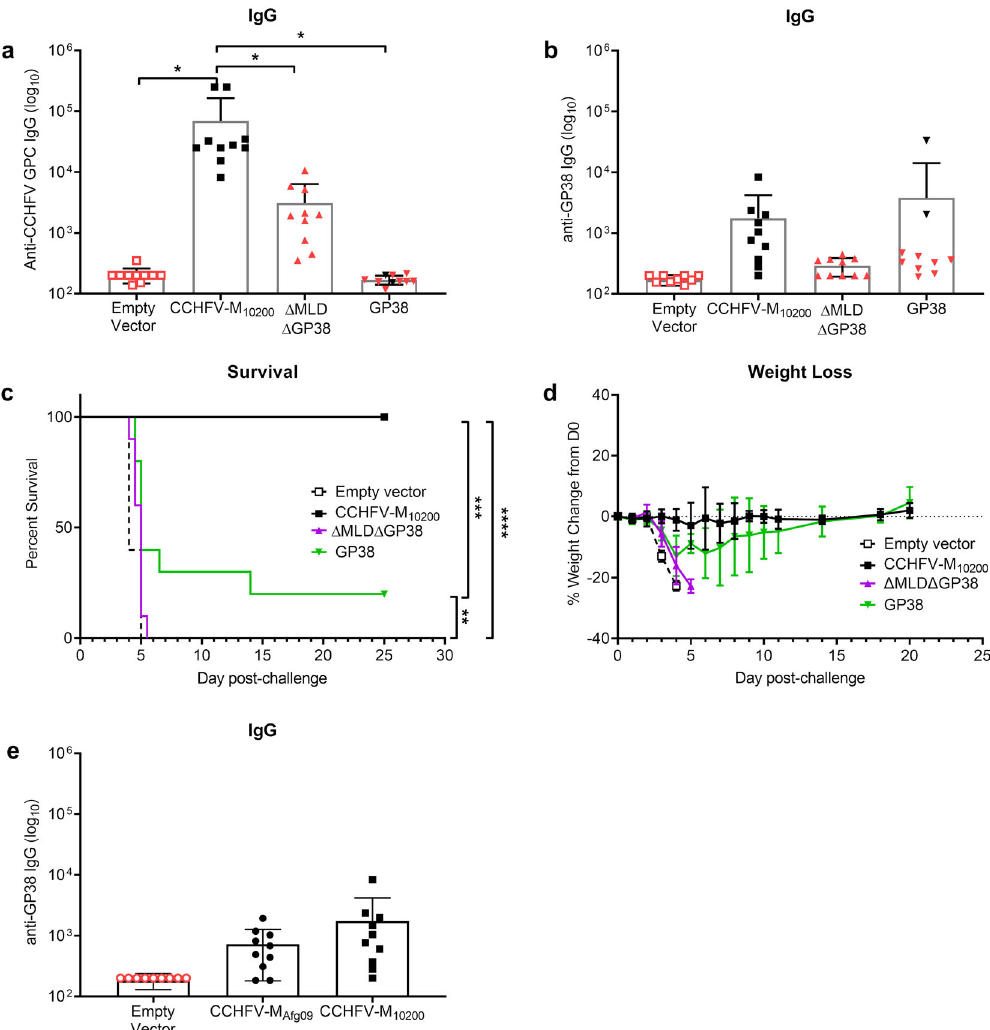
Fig. 9 GP38 vaccination is partially protective against homologous challenge. Groups of 10 female C57BL/6 mice were vaccinated with 50 μ g empty vector, CCHFV-M 10200 , Δ MLD Δ GP38, or GP38 on days 0, 21, and 42 by IM-EP. a Sera antibody responses were analyzed 21 days post third vaccination for anti-CCHFV endpoint titers by ELISA. Mice that succumbed to viral challenge are shown in red. b Anti-CCHFV-IbAr 10200 GP38 IgG responses in vaccinated mice. c Group survival and ( d ) weight change following challenge with 100 PFU by the IP route with CCHFV-IbAr 10200. Vaccinated C57BL/6 mice were transiently immunosuppressed prior to challenge. e Anti-CCHFV-IbAr 10200 GP38 IgG ELISA titers in mice vaccinated with 50 μ g empty vector, CCHFV-M 10200 , or CCHFV-M Afg09 . Data are the group mean averages ± SD. * p <